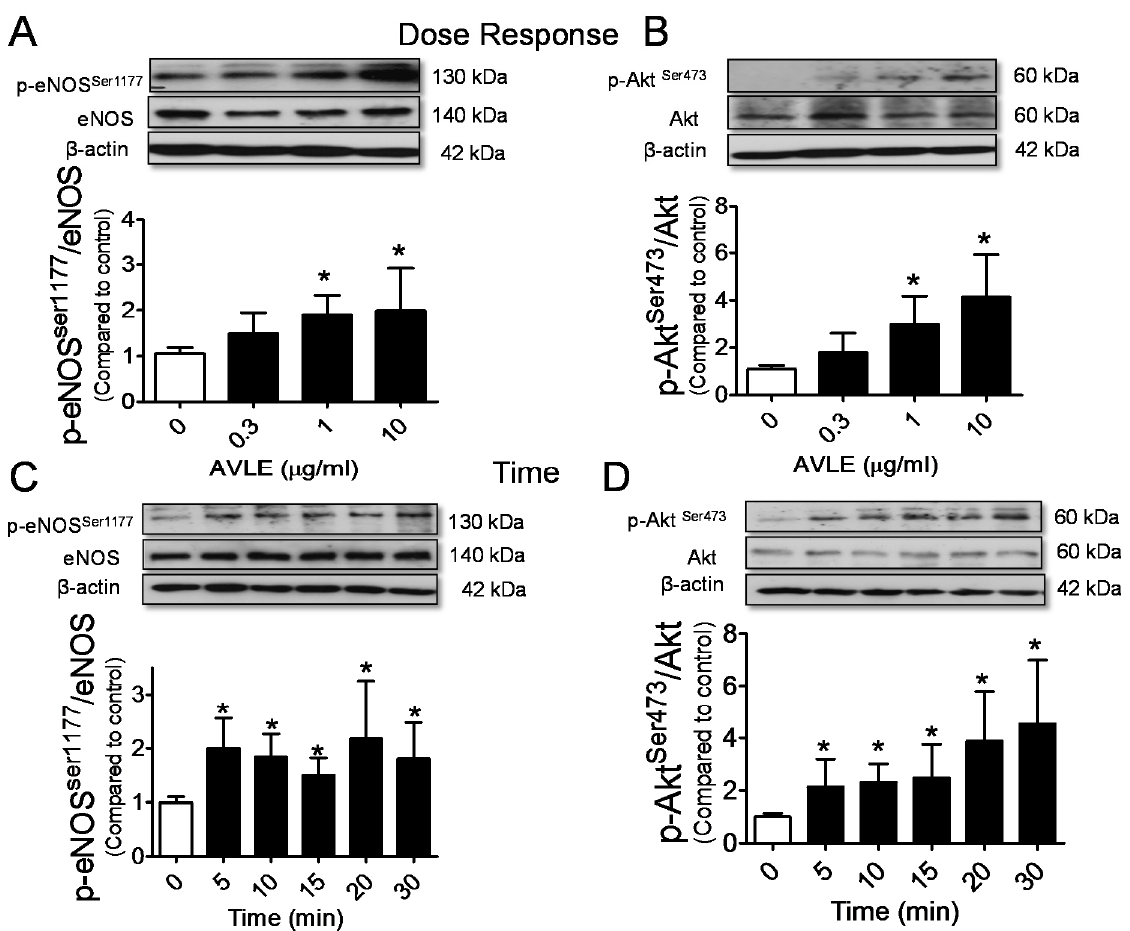
Figure 3. AVLE upregulated phosphorylated eNOS ( A ) and Akt ( B ) protein expression in a concentration-dependent manner (0, 0.3, 1 and 10 µg/mL) in HUVECs. AVLE (10 µg/mL) steadily upregulated phosphorylated eNOS ( C ) and Akt ( D ) protein expression in HUVEC in interval 30 min time points. Results are means ± SEM ( n = 3). * p < 0.05 compared to control.